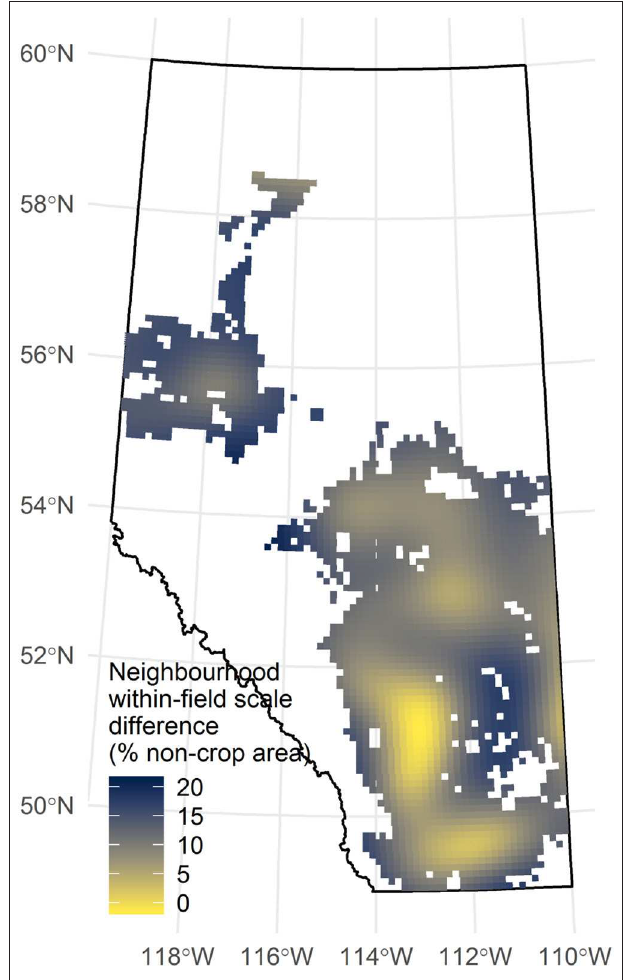
FIGURE 8 | The difference in the predicted non-crop area between the within-field (150–400m) and neighborhood (500–1,006m) scales for each of the 2,480 survey townships with agricultural land. Model predictions exclude all environmental covariates but include spatial